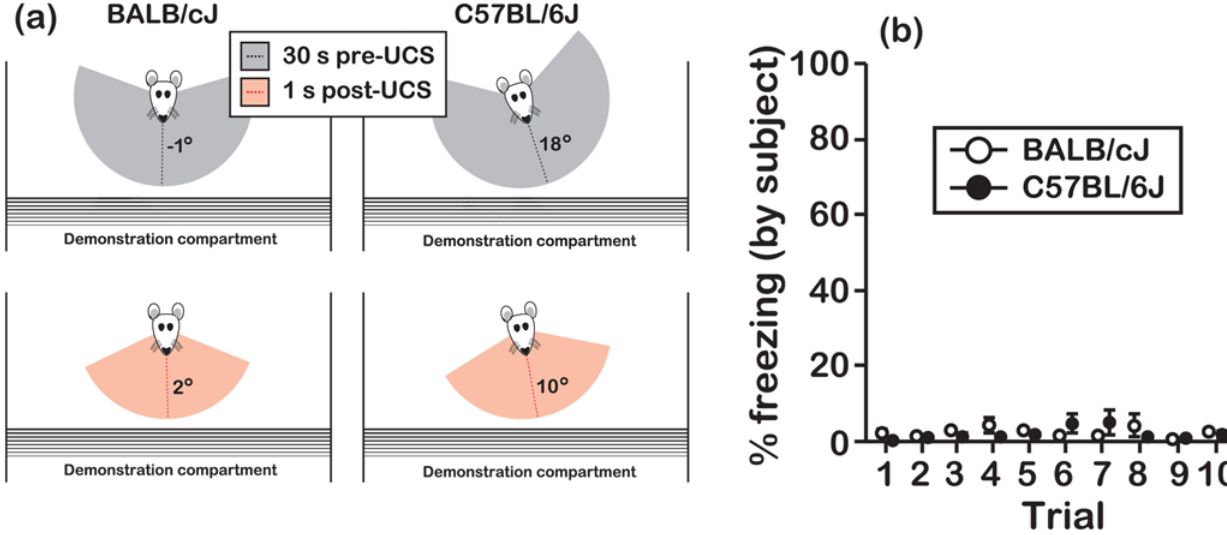
Figure 4. Head orientations and freezing responses of subjects during exposure to object distress. (a) Estimates of subject head orientations were extracted from freeze-frames of video recordings at 2 time-points with respect to UCS presentation to objects (30 s pre-UCS and 1 s post-UCS). The longitudinal axis of the subject’s head, running parallel with the sagittal midline, was referenced at 15 u increments. A 0 u head orientation was defined by the longitudinal axis of the subject’s head forming a right angle with the steel dowels that separated the observation and demonstration compartments. Prior to presentation of the UCS to objects, BALB ( left panels ; N=16 mice; age=7–8 wks) and B6 ( right panels ; N=8 mice, age=7–8 wks) subjects were orientated towards the demonstration compartment (mean head angle=dotted black lines, std. dev.=grey shaded area). Following presentation of the UCS to objects, subject head orientations were more consistently directed at objects (depicted by red dotted lines and pink shading), as indicated by a < 2-fold reduction in variability of head orientations (Brown-Forsythe ANOVA, P , 0.001 for both BALB and B6 subjects). (b) The freezing responses of these subjects were minimal and strain-independent during the 30-s period following presentation of the UCS to objects. Data in panel (b) are presented as the mean 6 s.e.m.